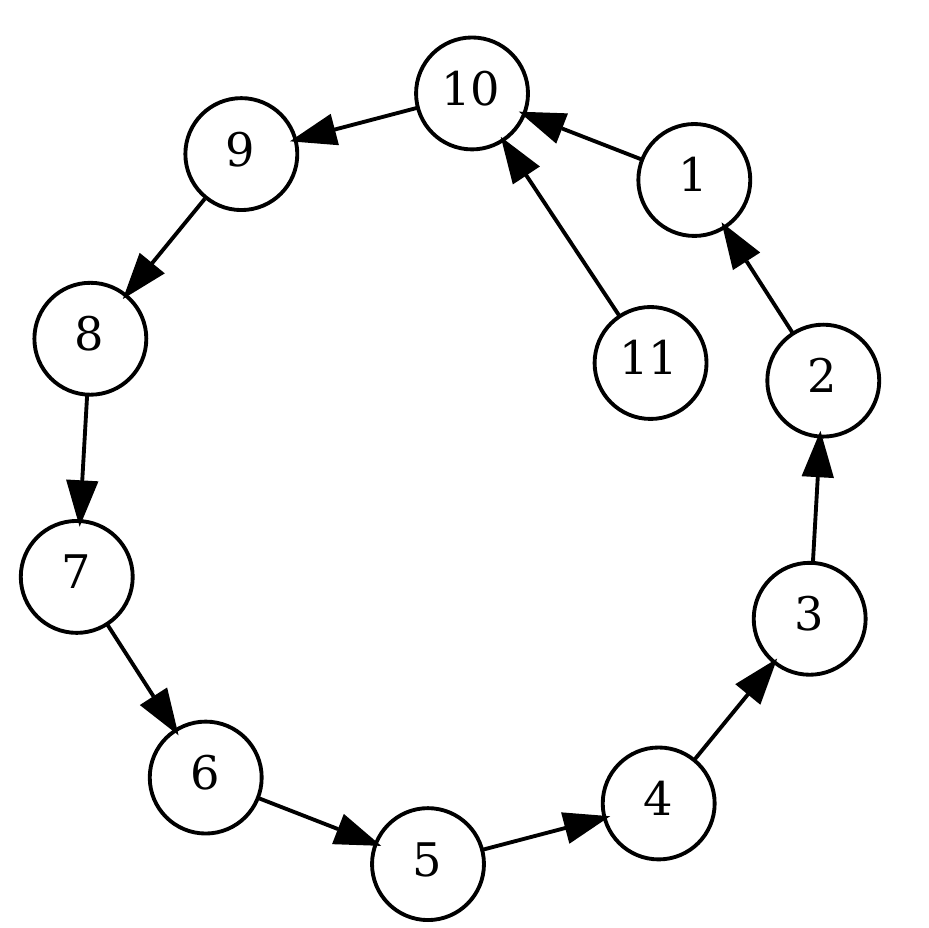
Figure 1. An example of a connection diagram for a system of 11 Hodgkin–Huxley [24] neurons, 10 of which are connected by a unidirectional couplings with a delay; the neuron No. 11 is used to begin